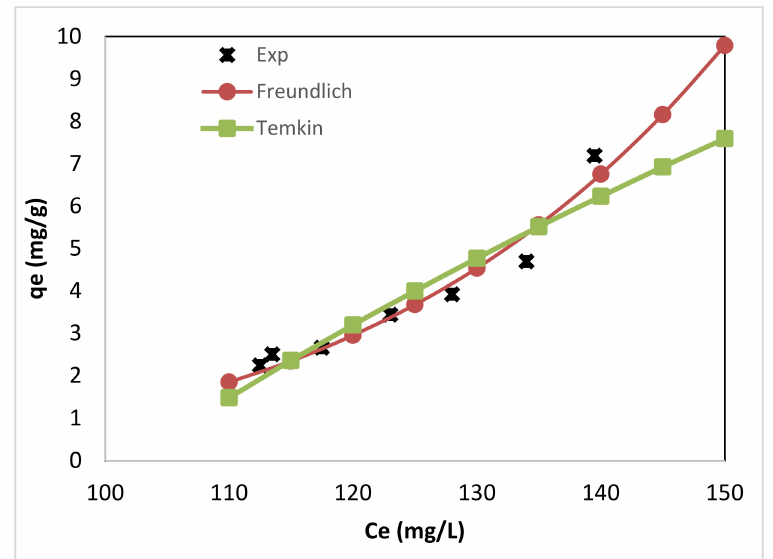
Figure 5. Comparing the empirical Freundlich and the Temkin isotherm with the experimental data for adsorption of FFA on the alkali residue adsorbent, at a temperature of 293 K. Non-conformation of the data into a Langmuir adsorption isotherm model and fit- ting of the data to the Freundlich isotherm model suggested a heterogeneous and non- uniform sorbent surface. Further, this is an indication of the multilayer formation of the sorbed